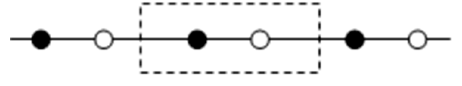
Figure 20. The discrete complex structure model.